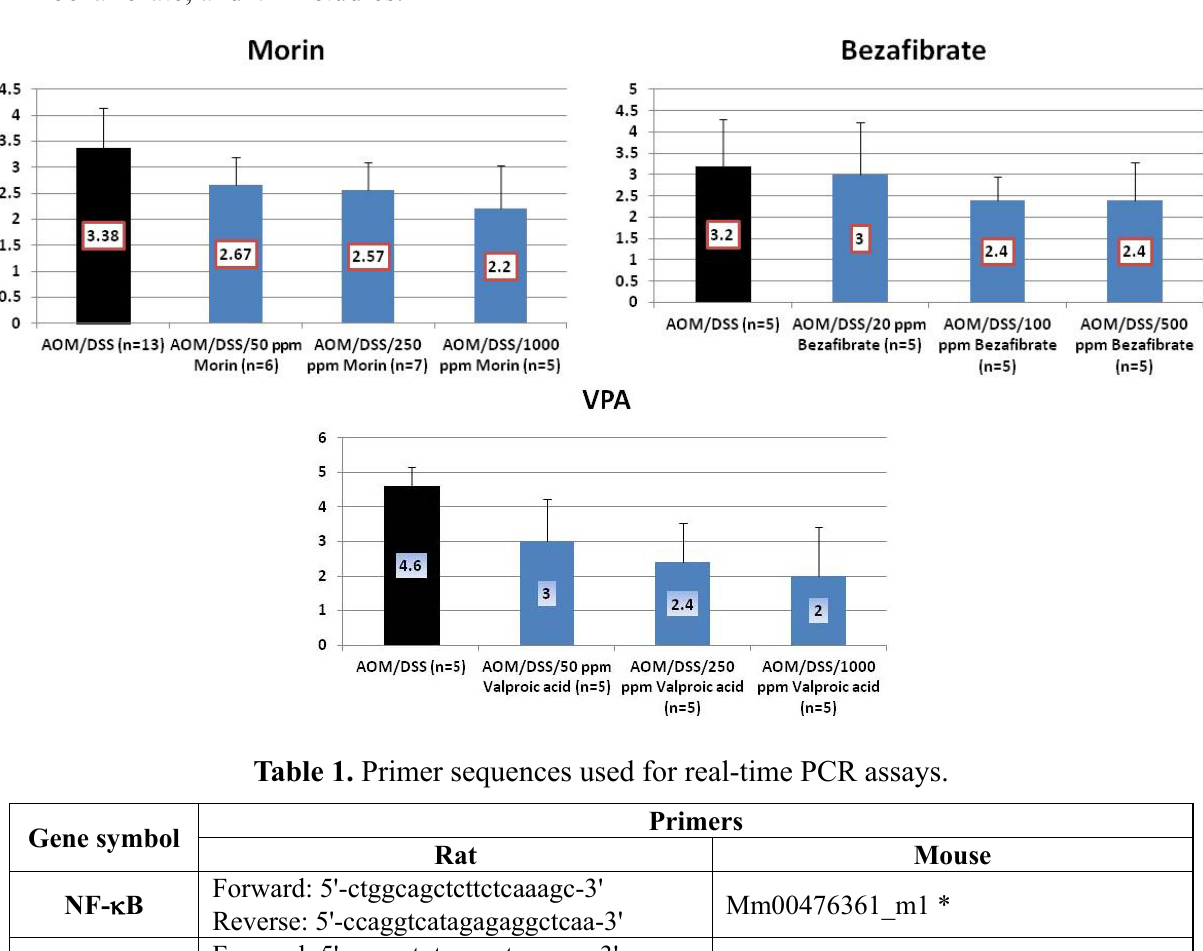
Figure 13. mRNA expression of HIF-1 α in the colorectum of mice or rats from the morin, bezafibrate, and VPA studies.